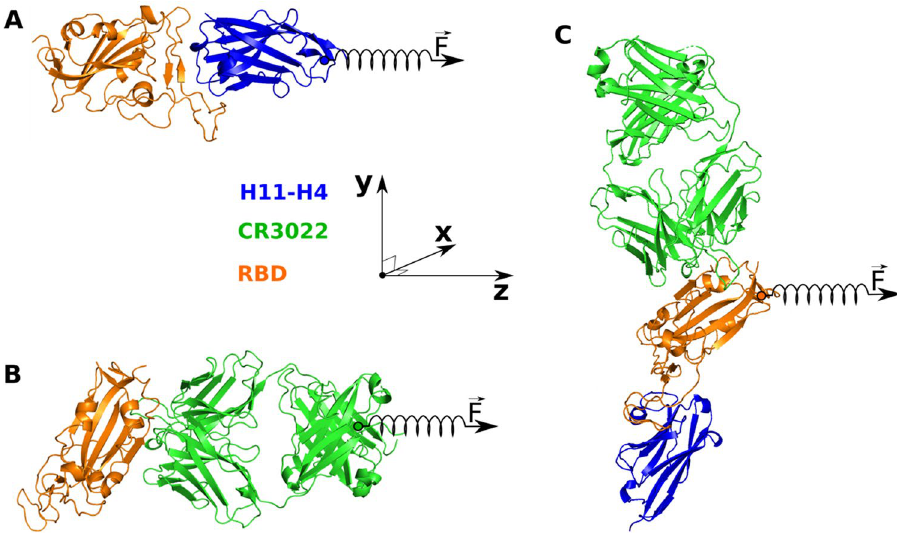
Figure 2. Structure of H11-H4 + CR3022–RBD retrieved from PDB with ID 6ZH9. RBD is shown in orange, while green and blue describe CR3022 and H11-H4. ( A ) H11-H4–RBD complex, external force the H11-H4 nanobody through a dummy atom connected to a spring. ( B ) CR3022–RBD complex, to the CR3022 antibody. ( C ) H11-H4 + CR3022–RBD complex, SMD simulations is shown with a spring along the